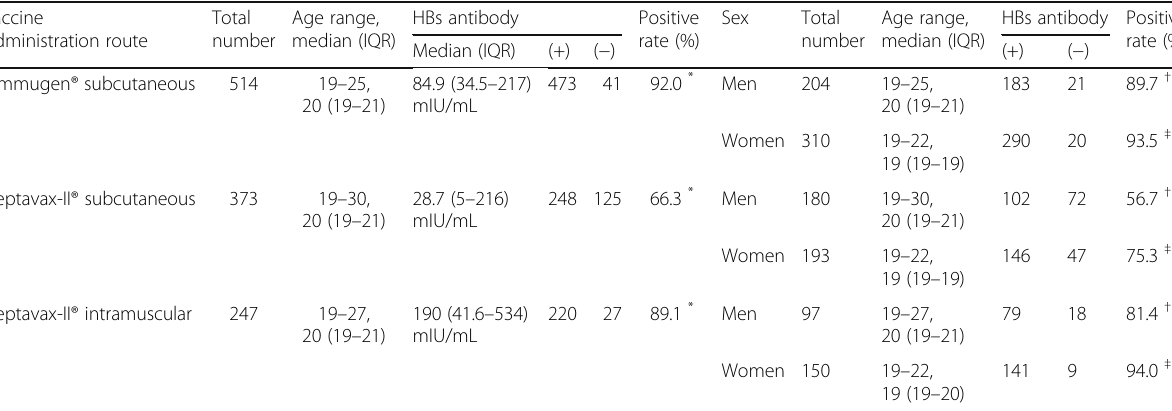
Table 2 Positive rate of HBs antibody after HB